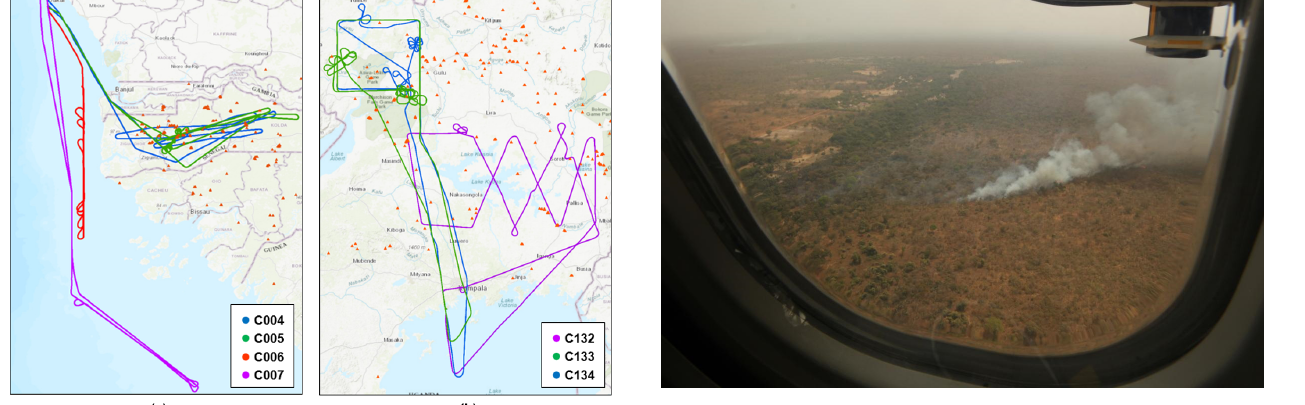
Figure 2. Photograph of Senegalese wildfire taken from aboard the FAAM ARA during flight C005 of the MOYA-I